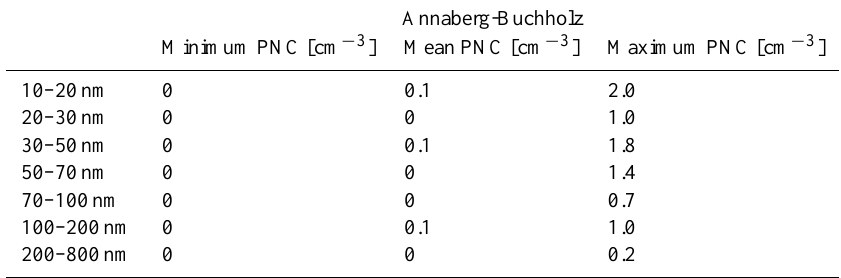
Table 1. Results of the zero-air measurements from 1 August 2012 to 1 August 2013 for the Annaberg-Buchholz site.